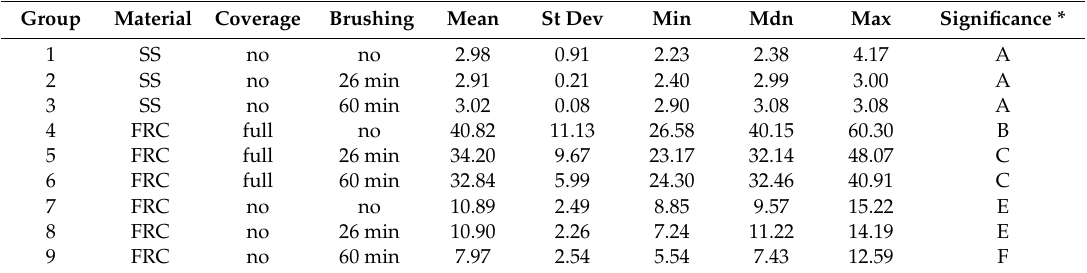
Table 1. Descriptive statistics of the di ff erent groups at maximum load (N).